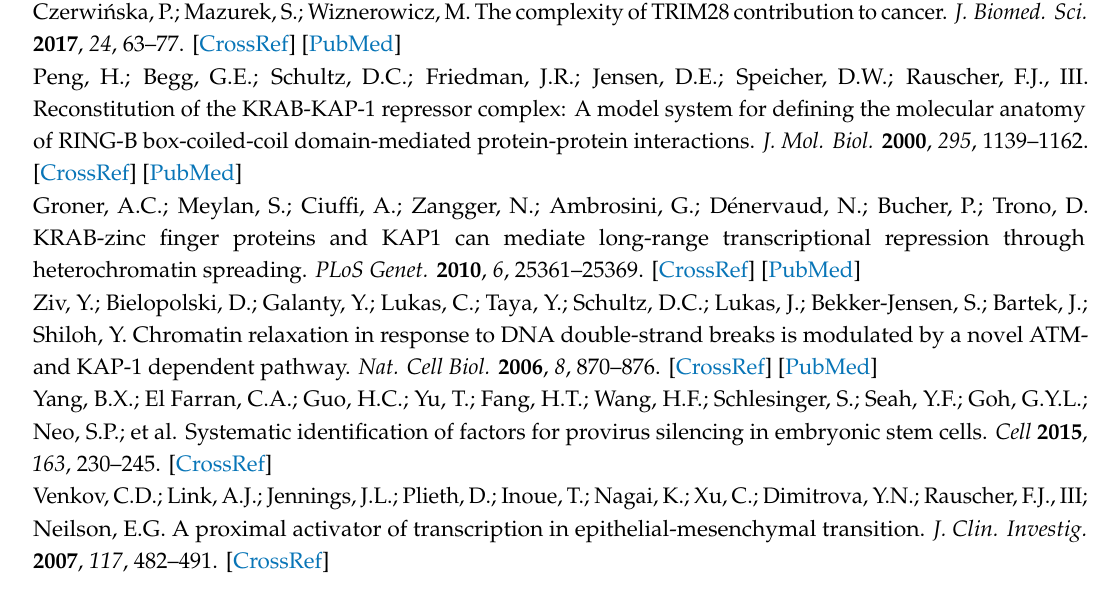
Table S2: Immune-associated scores determined for the SKCM TCGA samples; Table S3: Melanoma cell line characteristics. Table S4: The statistical significance corresponding to Figure 3A. Table S5: Stemness-associated scores calculated for the SKCM TCGA